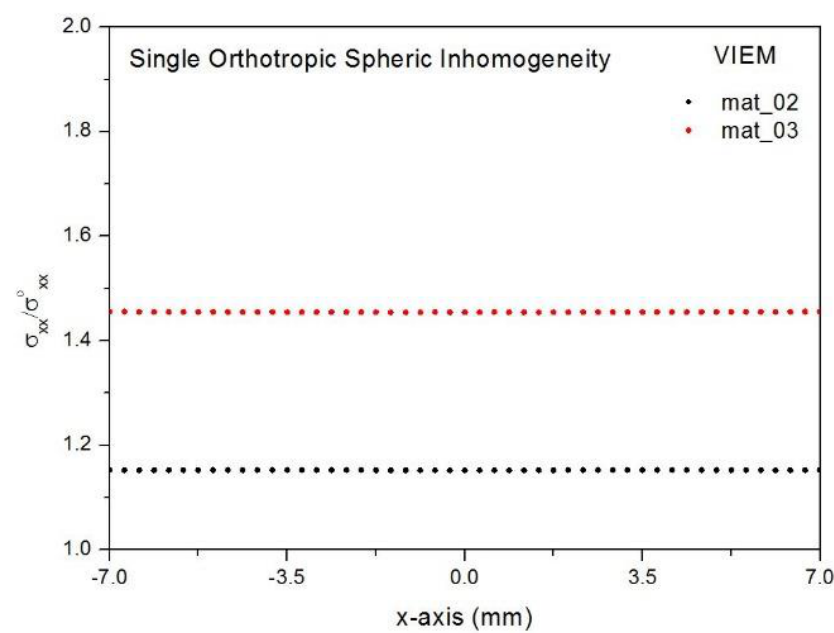
Figure 15. Numerical results using the volume integral equation method (VIEM) for the normalized tensile stress component ( σ xx / σ oxx) along the x-axis inside the orthotropic spherical inclusions with a radius of 7 mm under uniform remote tensile loading.